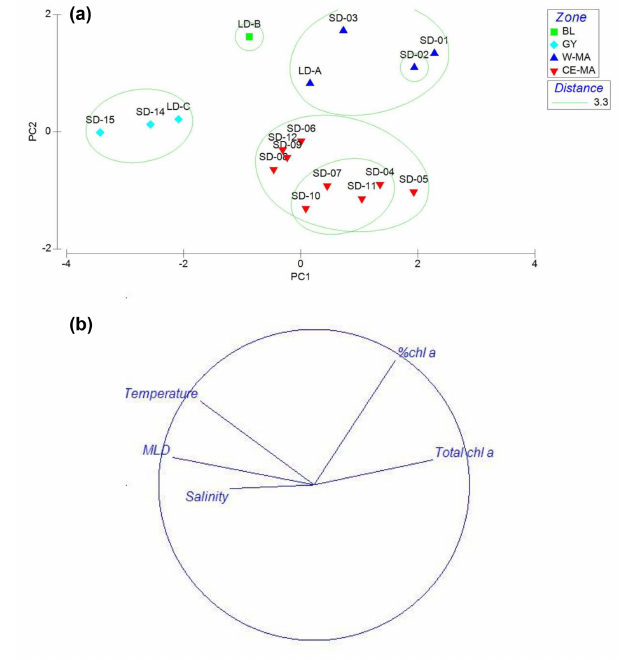
Figure 2. PCA on environmental variables: mixed-layer depth (MLD); total Chl a concentration (Chl a + Phae), % Chl a (ratio Chl a /Chl a + Phae), temperature, salinity averaged over the upper 0–200m of the water column. Plots of the 15 stations (a) and vari- ables (b) on the first factorial plan. The green circles delimit the clusters defined at a distance of 3.3: W-MA: western Melanesian archipelago; CE-MA: central and eastern Melanesian archipelago; BL: station B, blooming conditions; GY: subtropical